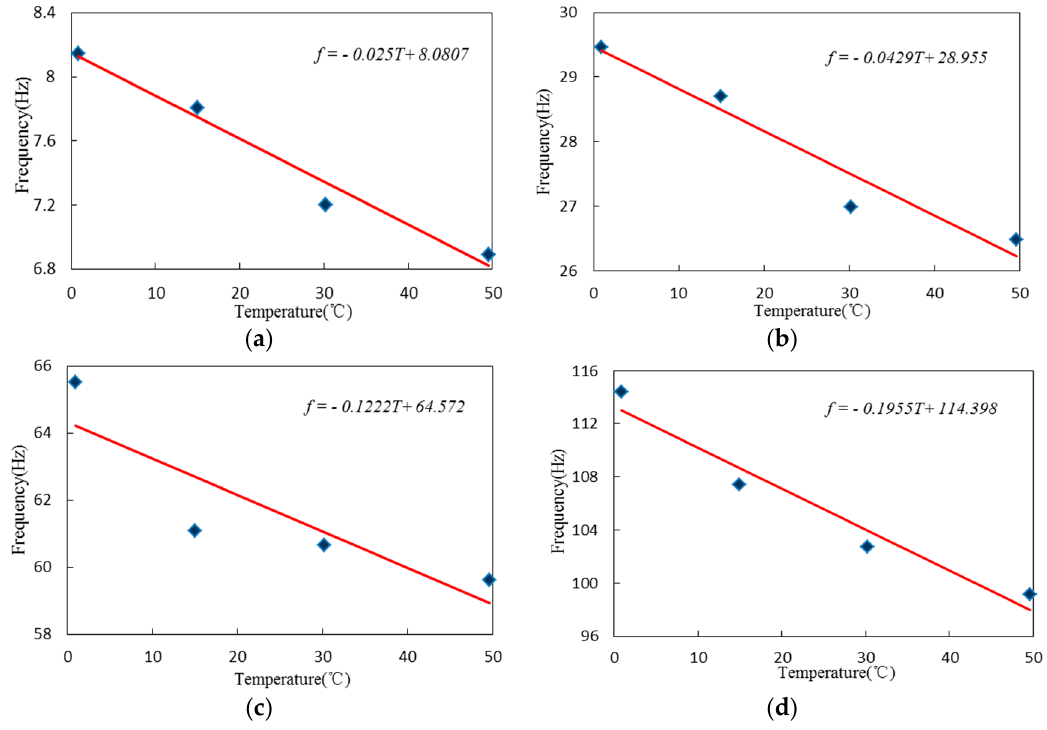
Figure 11. Modal frequencies of linear regression model under different temperature. ( a ) 1st mode. ( b ) 2nd mode. ( c ) 3rd mode. ( d ) 4th mode. Table 2. Slope coefficients and intercepts for the first four natural frequencies.